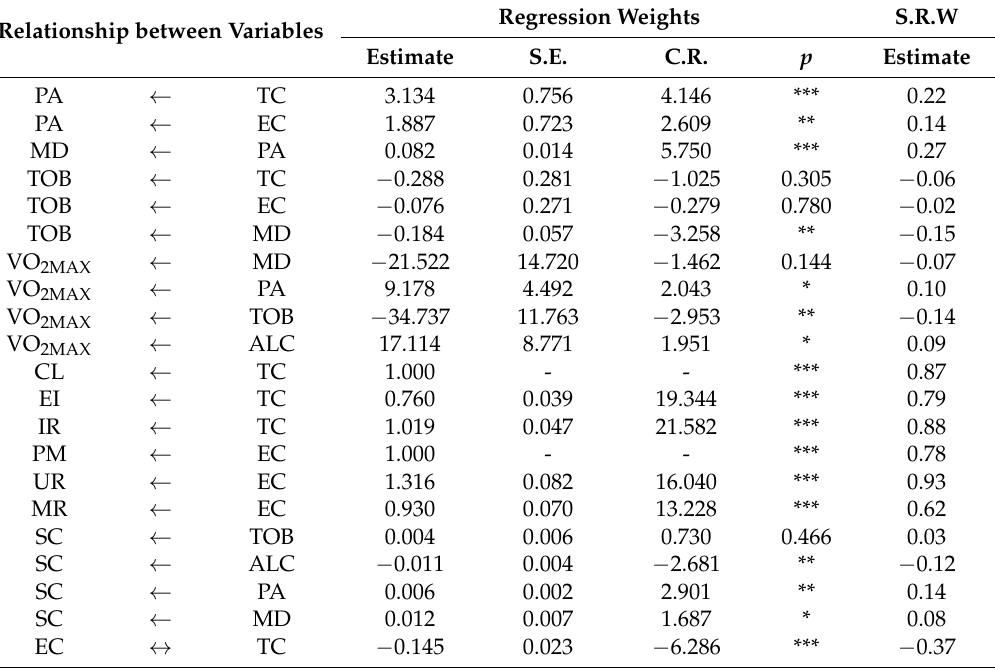
Table 1. Weights and standardized regression weights for